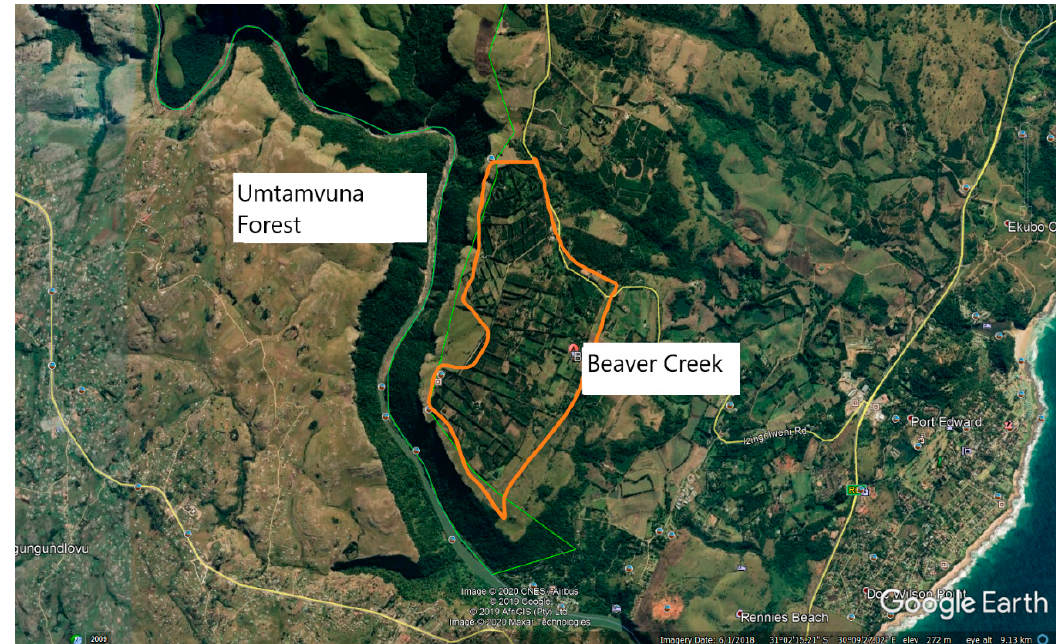
Figure 1. A Google Earth image showing the close proximity of Beaver Creek Coffee plantation to Umtamvuna forest. (Image © 2020 Maxar technologies)